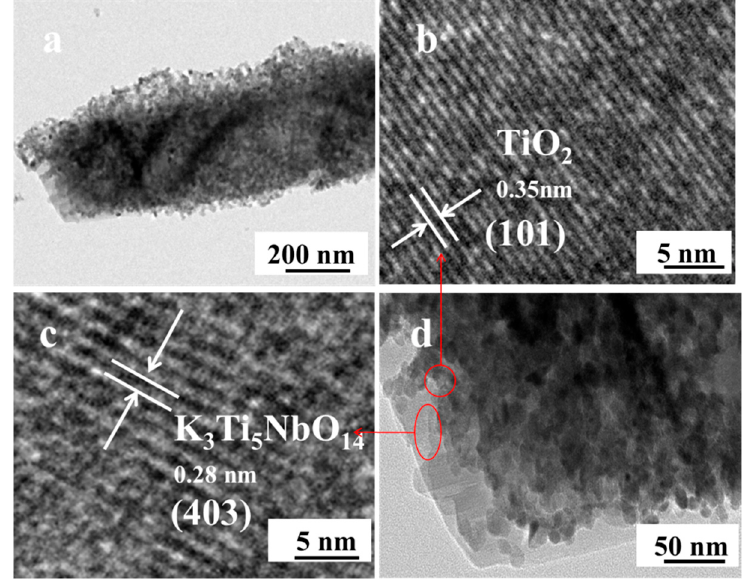
Figure 3. ( a,d ) TEM and HRTEM images of NTNT; ( b,c ) The enlarged HRTEM images of NTNT. Figure 3. ( a , d ) TEM and HRTEM images of NTNT; ( b , c ) The enlarged HRTEM images of